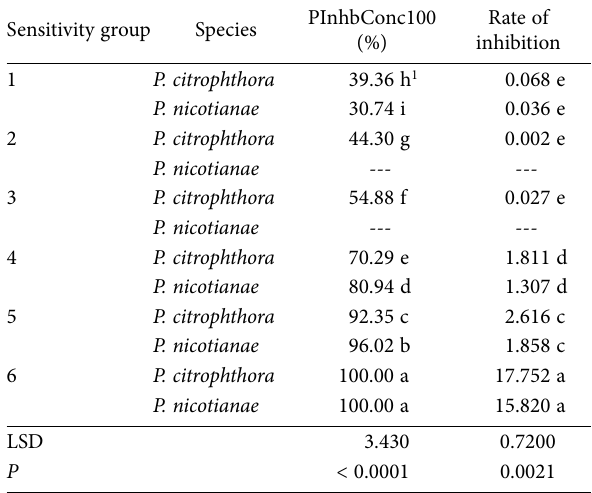
Table 2. Mean PInhbConc100 and rate of inhibition values for Phytophthora citrophthora and Phytophthora nicotianae isolates, grouped into mefenoxam sensitivity groups 1–6, following in vitro exposure to different mefenoxam concentrations.